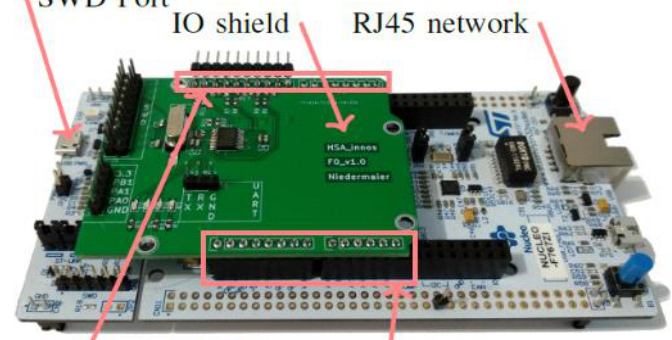
Figure 6. IoT device for simulation.